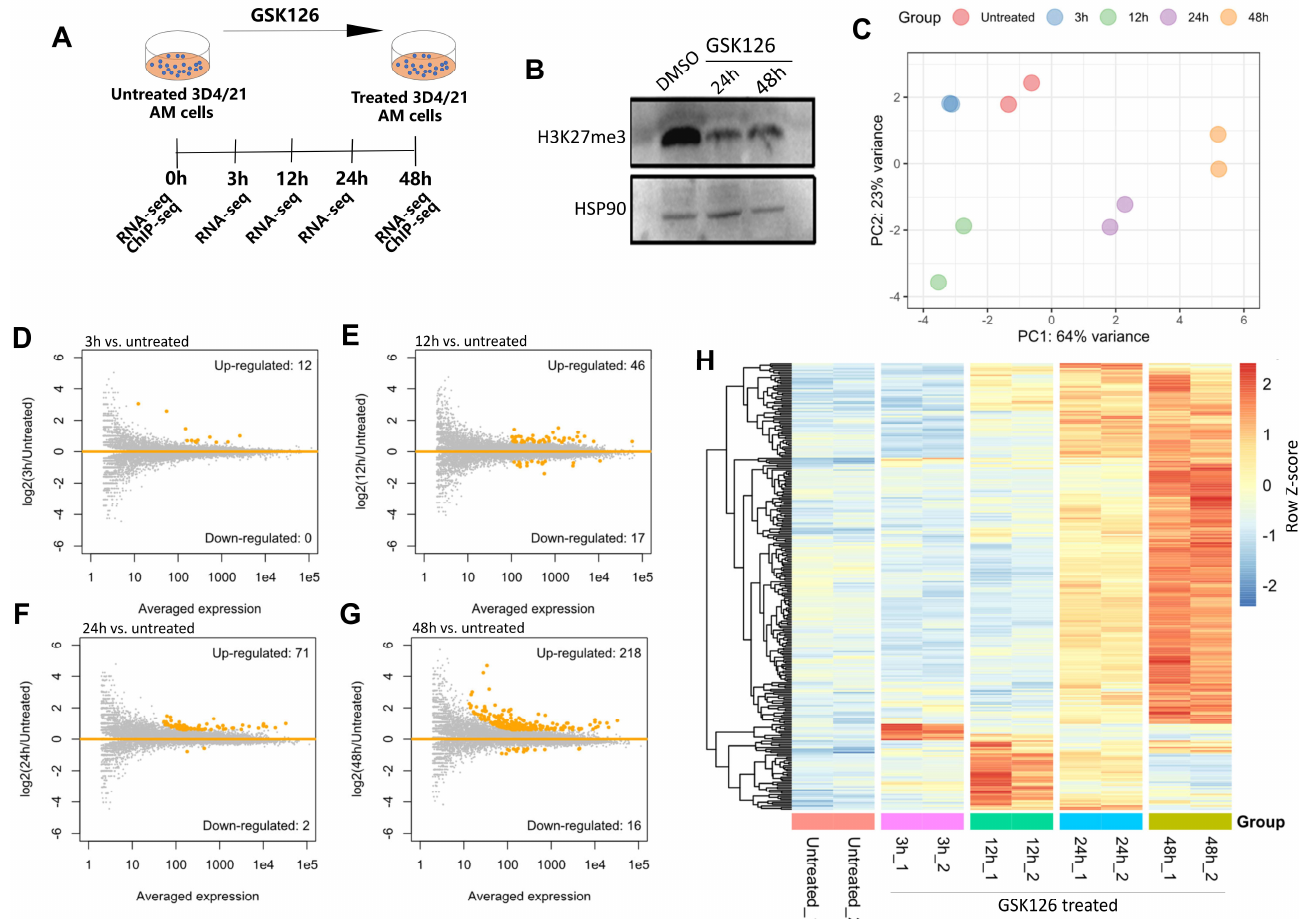
Figure 1. Global transcriptomic alterations in porcine alveolar macrophages after EZH2 inhibition. ( A ) Scheme for the GSK126 treatment of the porcine 3D4/21 AM cells and subsequent experiments. ( B ) Western blot shows the reduction in global H3K27me3 abundance after treatment of the 3D4/21 AM cells with the EZH2 inhibitor GSK126. HSP90 in the bottom panel was used as control. ( C ) PCA plot based on transcriptomic data shows the relationship between different samples. ( D-G ) MA plots show the transcriptional alteration after different time periods (i.e., 3h, 12h, 24h, 48h) of GSK126 treatment. ( H ) Heatmap shows the expression pattern of the upregulated genes at different times (i.e., 3h, 12h, 24h, 48h) after GSK126 treatment.